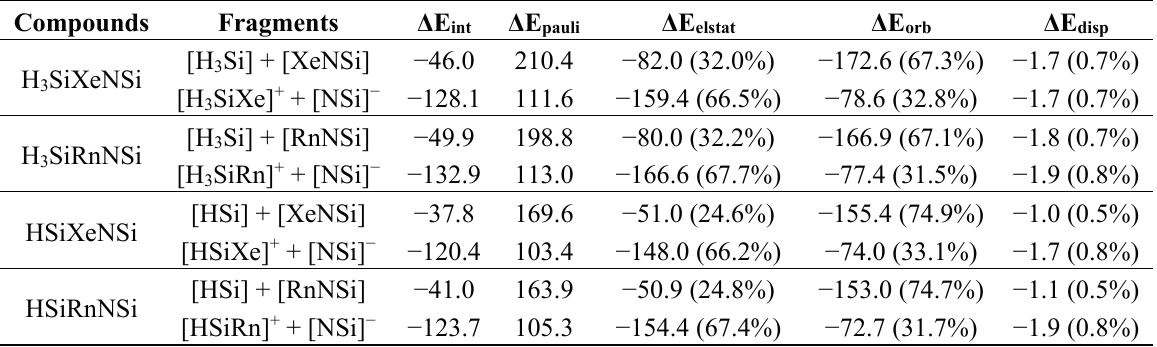
Table 5. Energy decomposition analysis (EDA) results of the H 3 SiNgNSi and HSiNgNSi molecules studied at the revPBE-D3/TZ2P//MP2/def2-QZVPPD level. All of the energy terms are in